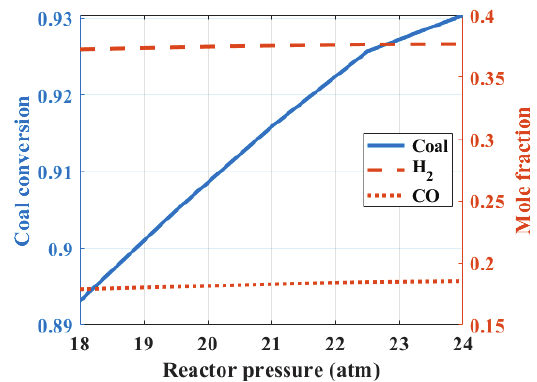
Fig. 6 – Effects of reactor pressure on outlet solid conversion and syngas composition (inlet gas temperature = 644